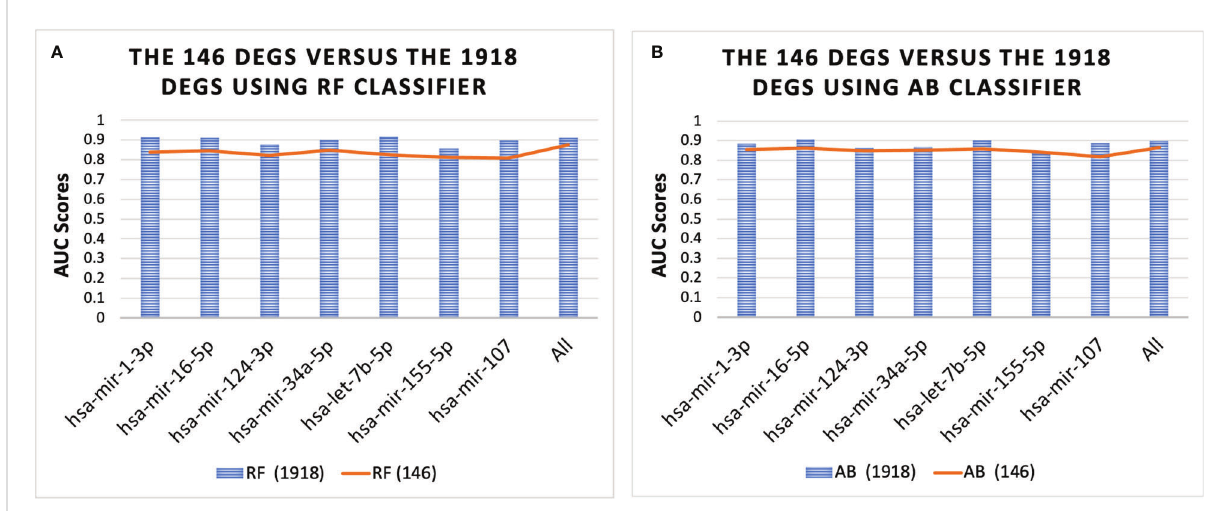
FIGURE 4 Performance of 146 DEGs and 1918 DEGs using the RF (A) and AB (B) classi fi er. The results further show that the DEGs associated with each miRNA could distinguish between the T2D sample and the healthy controls, as they all achieved an average AUC for the classi fi ers above 0.80. Furthermore, the results for all miRNAs were similar, with average AUC scores ranging from 0.84-0.87, except for the set of genes associated with miRNA hsa-mir-107, which had the lowest scores with AUC = 0.78 for both classi fi